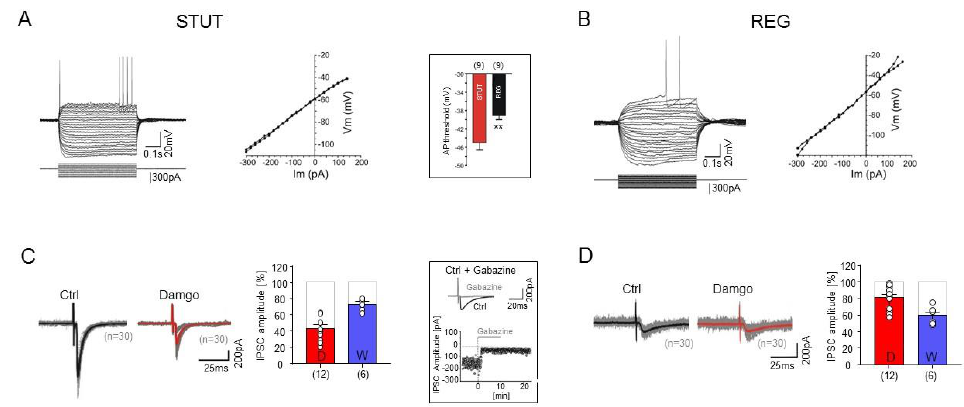
Figure 3. Effects of µ -opioid and cannabinoid receptor activation on IPSCs in GABAergic interneurons of superficial mEC. ( A , B ) Examples of STUT ( A ) and REG ( B ) voltage responses to hyperpolarizing and depolarizing current steps of different amplitudes (from − 300 pA to 280 pA, 20 pA steps, 500 ms, left ) with corresponding I-V plots ( right ). Inset (framed) depicts a clear difference in AP threshold between these two IN types. p value is given as ** ( p ≤ 0.01). ( C , D ) Example of opioid agonist damgo on IPSCs of INs [30 individual traces (n = 30) for IPSCs are shown in gray, and superimposed averaged trace is shown in black (control) and in red (damgo)], as well as summary bar charts of the reduced peak amplitudes for opioid (damgo, in red) and cannabinoid (WIN, in blue) agonists. Note faster inhibitory synaptic events in STUT than those in REG. Inset (framed) shows that IPSCs were completely abolished in the presence of the GABA A receptor antagonist gabazine.